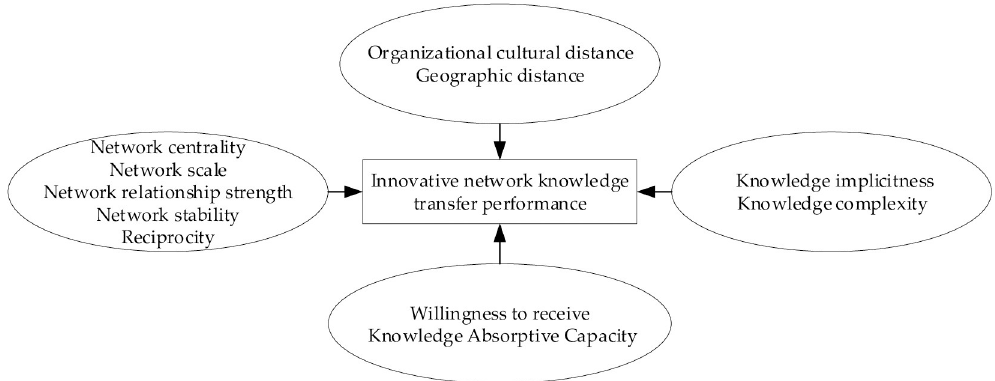
Fig 1. Conceptual model of AI industry innovation network knowledge transfer